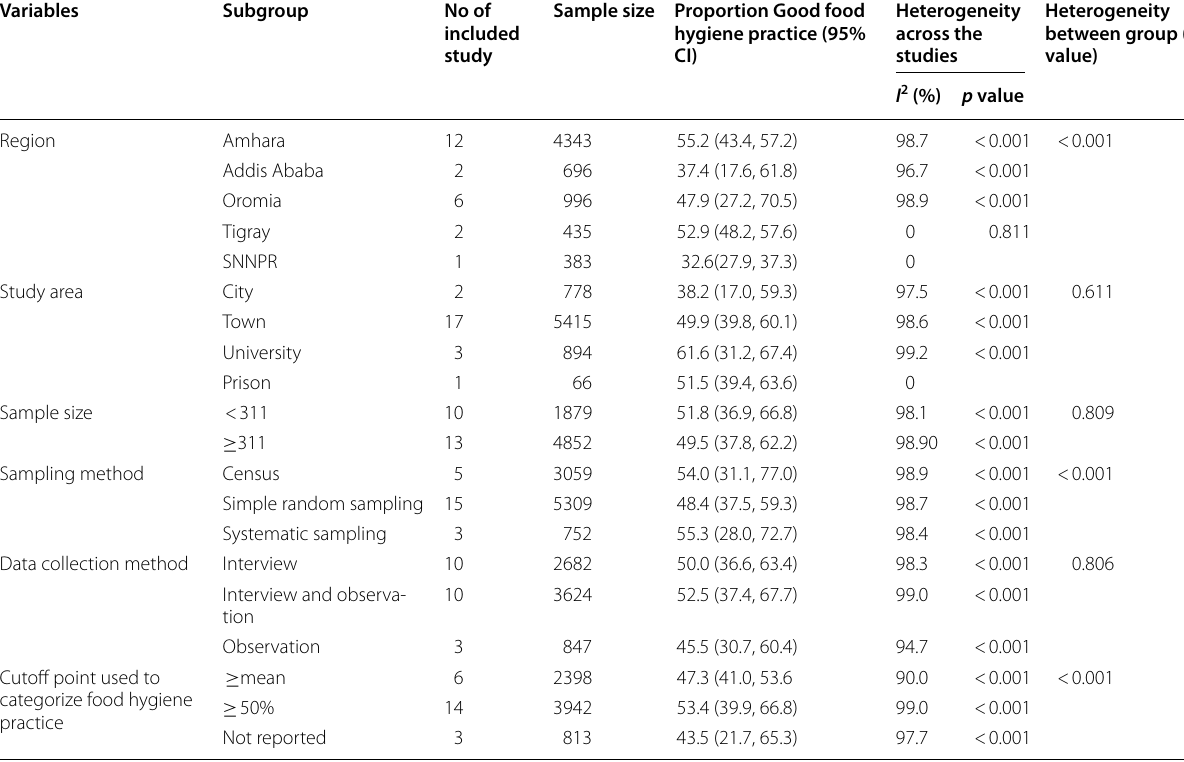
SNNPR Southern Nations, Nationalities, and peoples’ Region